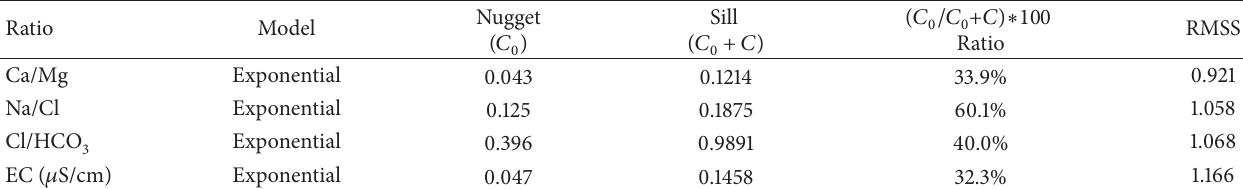
Table 1: Variographic parameters of the groundwater chemical